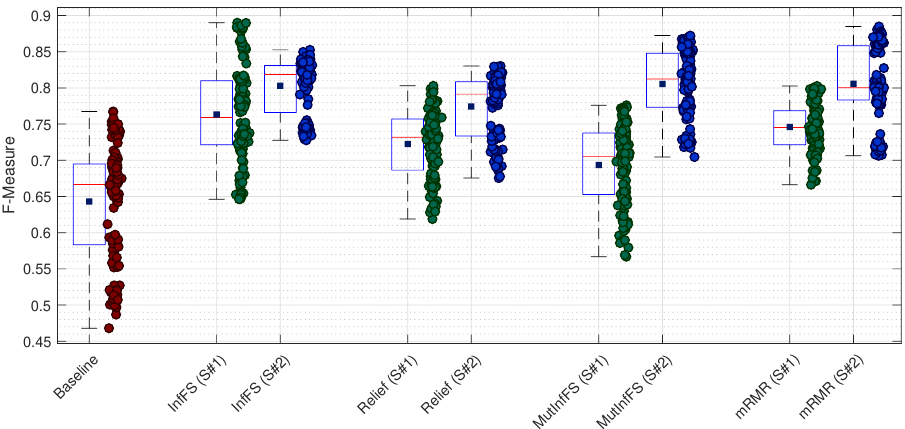
Figure 3. The attained F-Measure values for the kNN classification model w.r.t. each feature selection